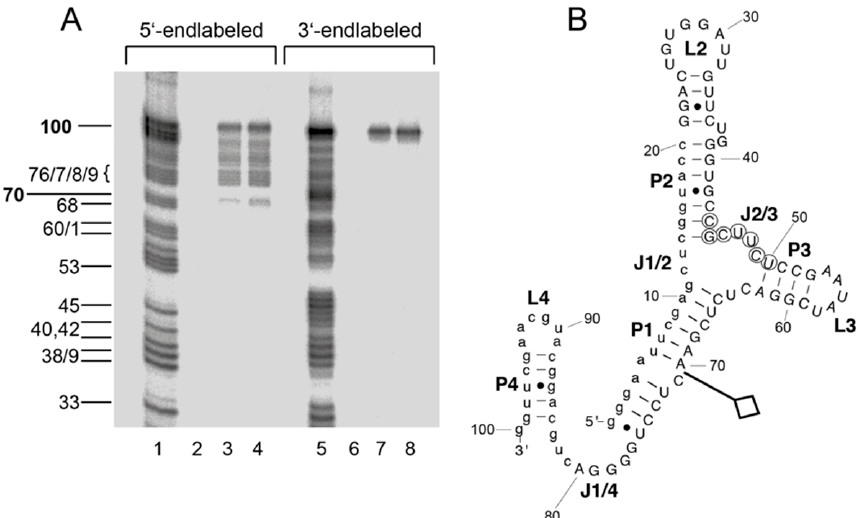
Figure 4. Boundary experiments to derive the minimum structure for efficient mLBP binding. ( A ) Boundary experiments with 5 ′ - or 3 ′ -endlabeled aptamer A011 determined by NC filter binding and 20% denaturing PAGE. Lanes 1 and 5, partial alkaline digest; lanes 3, 4, 7 and 8, intact RNA and alkaline hydrolysis fragments retained on NC filters after incubation for 1 h at 37 °C with 200 nM (lanes 3 and 7) or 400 nM (lanes 4 and 8) mLBP; lanes 2 and 6, as lanes 3, 4, 7 and 8, but omission of mLBP. Alkaline hydrolysis fragments of 5 ′ -endlabeled aptamer A011 are assigned on the left according to the numbering system shown in panel B. ( B ) The 3 ′ boundary, i.e., the utmost 3 ′ -terminal truncation that has no apparent effect on mLBP binding affinity, is indicated by the flag. With 3‘-endlabeled RNA, the 5 ′ boundary coincided with the native 5 ′ end, with possible tolerance for deletion of a few 5 ′ -terminal nucleotides (see panel A ).